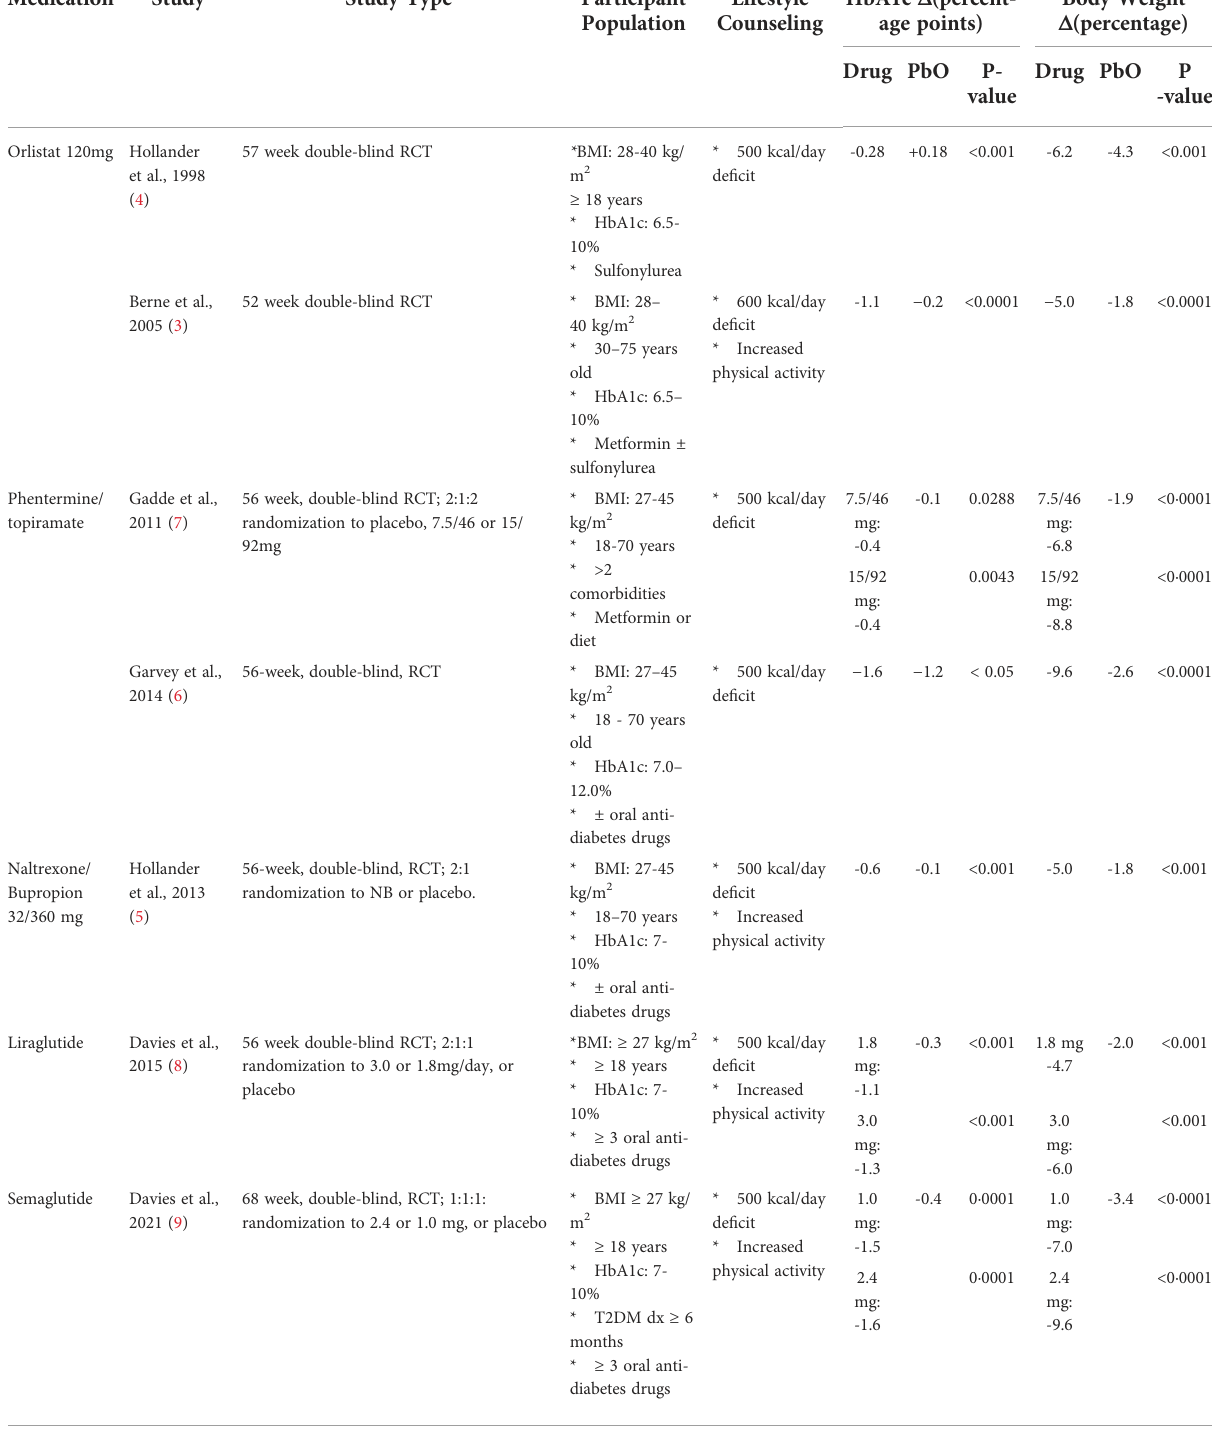
TABLE 1 Anti-obesity pharmacotherapy trials in adults with type 2 diabetes and obesity a